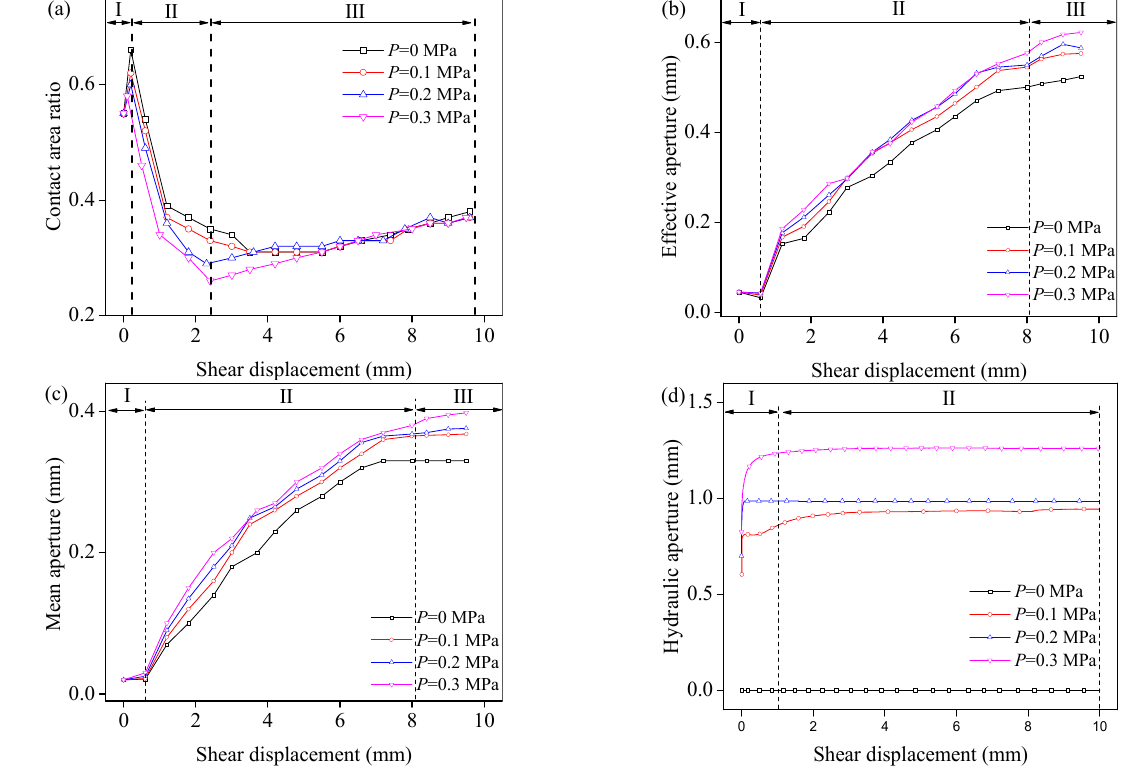
Figure 10. Evolution of ( a ) contact area ratio, ( b ) effective aperture, ( c ) mean aperture, ( d ) hydraulic aperture.